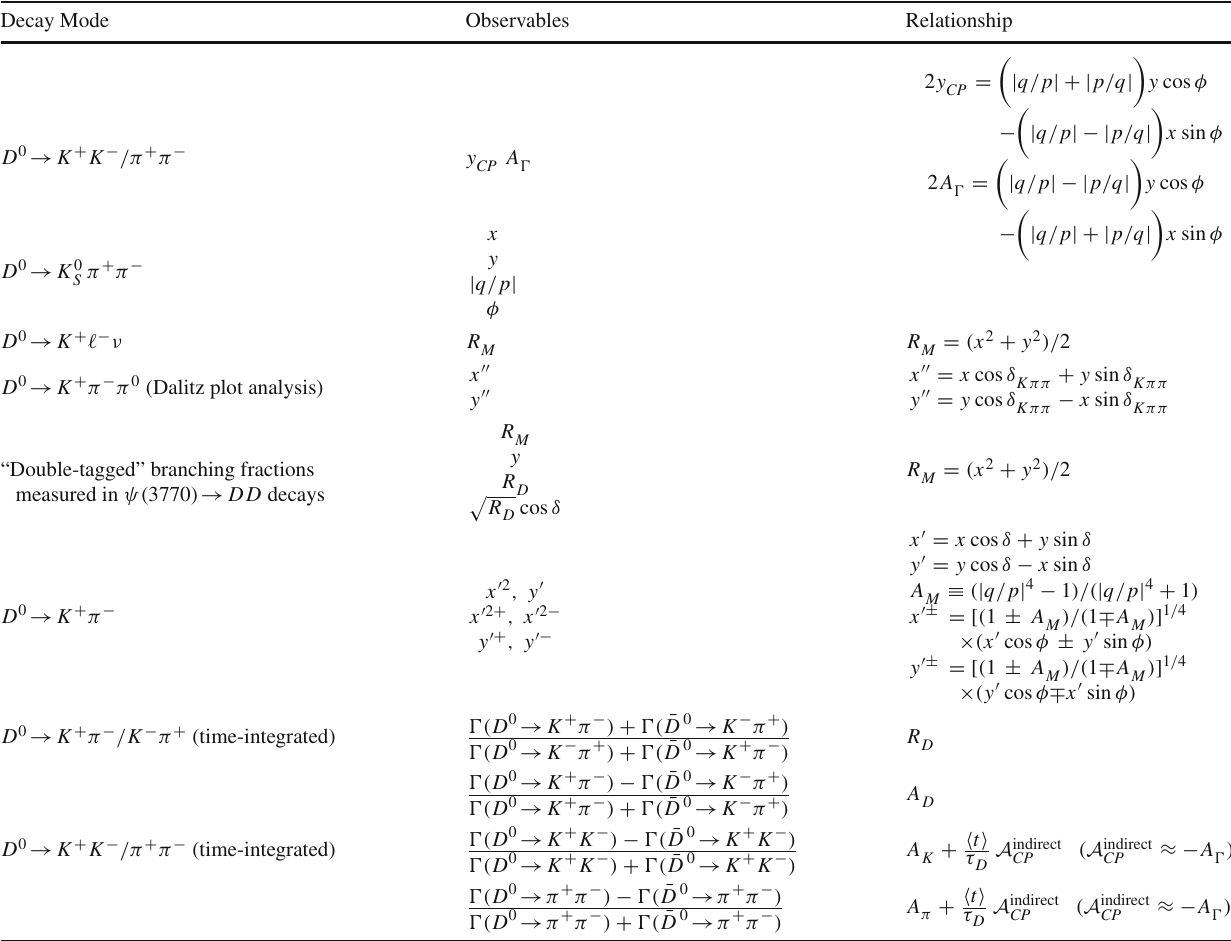
Table 258 Left: decay modes used to determine fitted parameters , R , A , A , A π , | q / p | , and φ . Middle: the observ- x , y , δ, δ K K ππ D D ables measured for each decay mode. Right: the relationships between